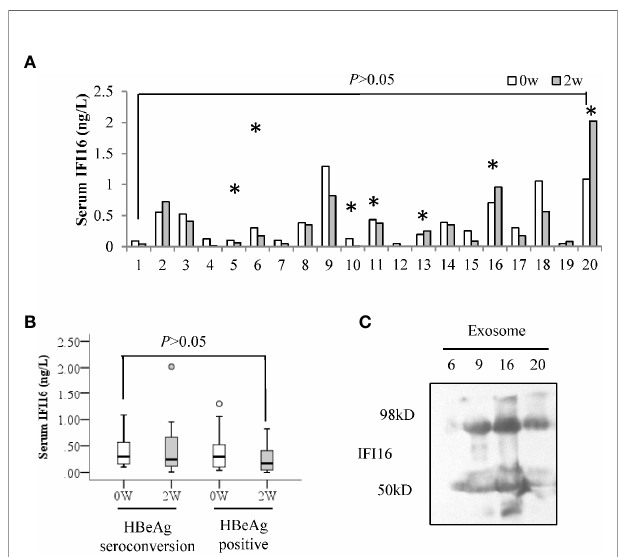
FIGURE 3 | Serum IFI16 levels in the CHB patients treated with interferon. Serum IFI16 levels at baseline and 2 weeks after Peg-IFN- a 2b treatment were comparatively analyzed by a paired Student ’ s t -test. * patients achieved HBeAg seroconversion at 24 weeks follow-up after Peg-IFN- a 2b therapy (A) . Patients were grouped according to the HBeAg seroconversion, and the changes of serum IFI16 after 2 weeks of Peg-IFN- a 2b treatment were tested by performing a Mann-Whitney U test (B) . IFI16 expression of sera exosomes from the CHB patients of baseline. A total of 500 m L of sera from four CHB patients was used to extract 100 m L of total exosomes. IFI16 expression of exosomes was detected using Western blot (C)